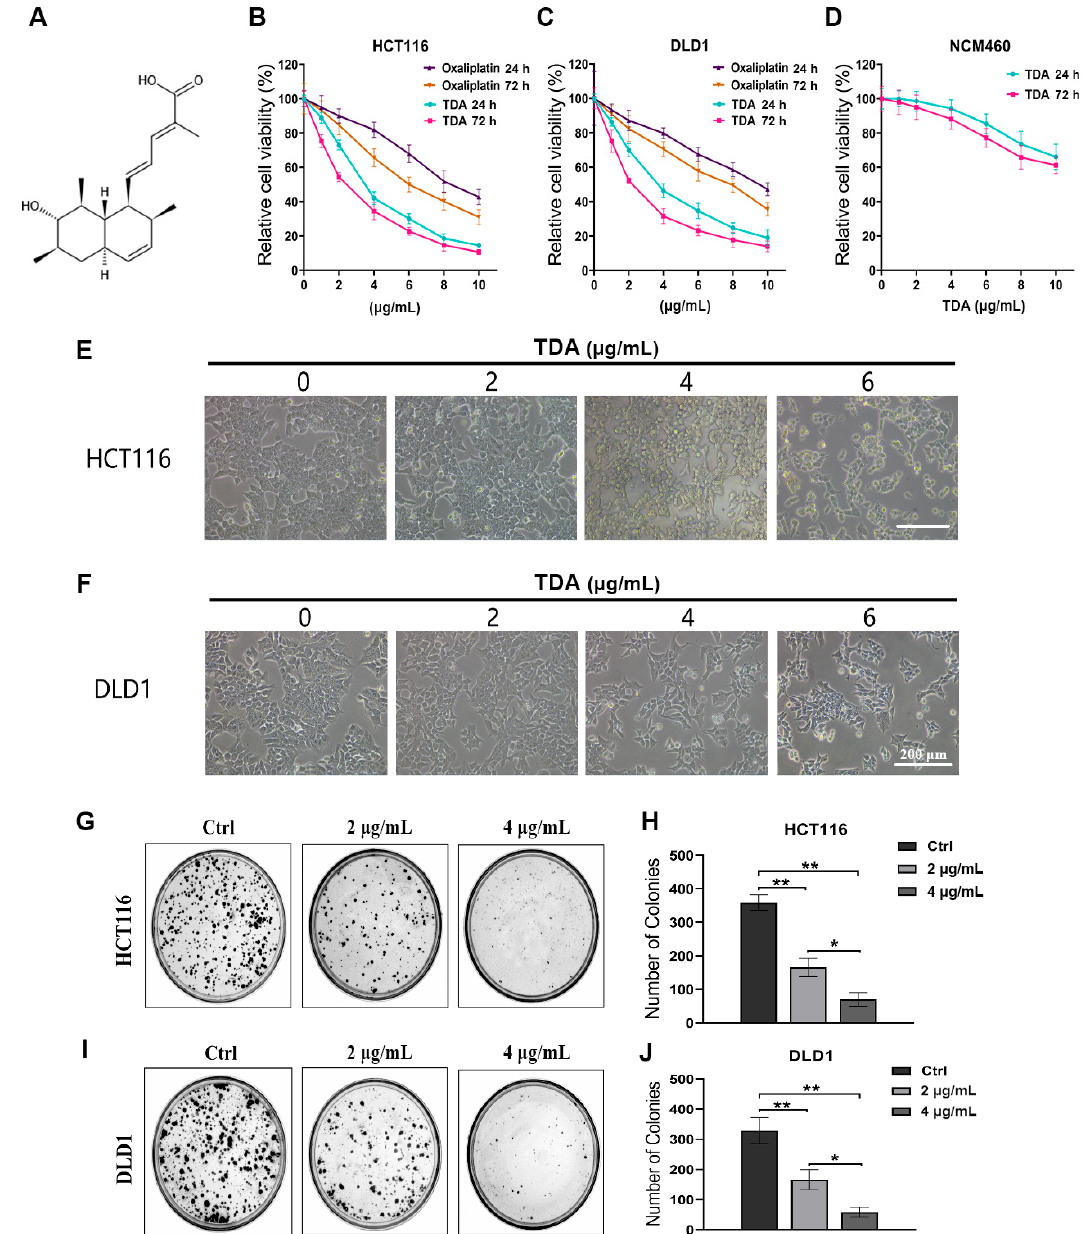
Figure 1. TDA inhibits cell viability in colon cancer cells. ( A ) The chemical structure of TDA. ( B , C ) HCT116 and DLD1 cells were treated with TDA or oxaliplatin (0, 1, 2, 4, 6, 8 and 10 µg/mL) for 24 or 72 h, respectively. Cell viability was measured by CCK-8 assay. The absorbance was measured at 450 nm. ( D ) NCM460 cells were treated with TDA (0, 1, 2, 4, 6, 8 and 10 µg/mL) for 24 or 72 h, respectively. Cell viability was measured by CCK-8 assay. The absorbance was measured at 450 nm. ( E , F ) Morphological observation of colon cancer cells treated with TDA at indicated concentration. ( G – J ) Colony formation assay of HCT116 and DLD1 cells treated with the indicated concentrations of TDA. Representative images ( G , I ) and quantification of colonies ( H , J ) was shown. Data are presented as the mean ± SD from at least three separate experiments. * p < 0.05; ** p < 0.01.